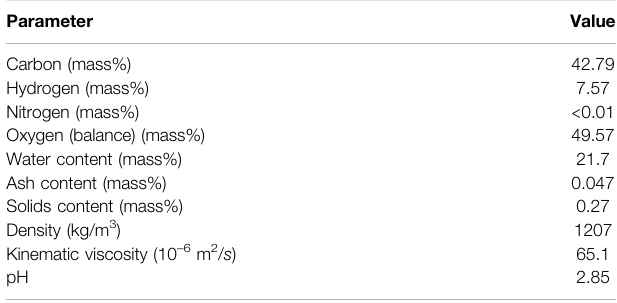
TABLE1| Physico-chemicalparametersoftheBCOfromBTG(Chiaramontietal., 2011). Here mass% indicates the percentage mass fraction.